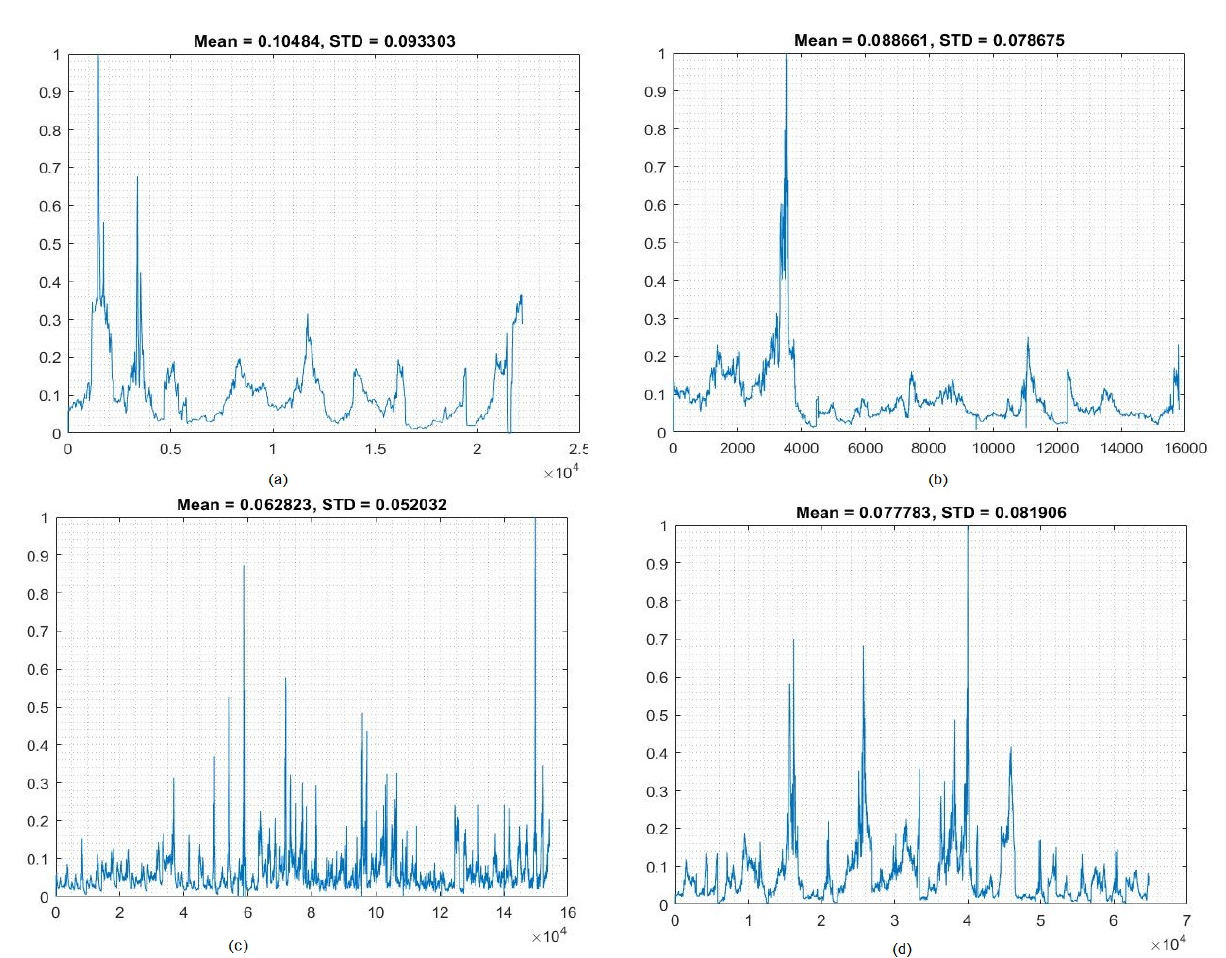
Figure 2. Normalization performance of the Saudi Stock Exchange ( a ) communication ( b ) energy, ( c ) financial and ( d ) industrial sectors.